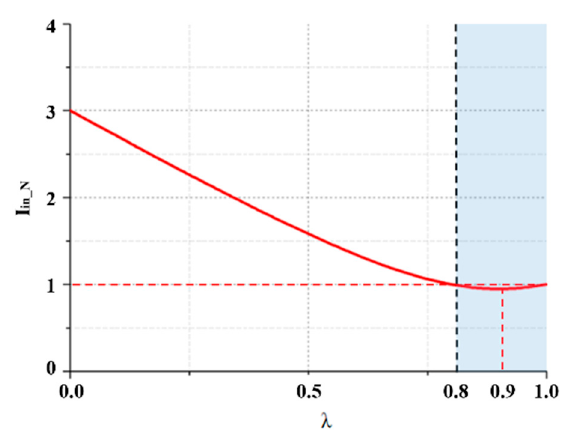
Figure 7. Normalized dual-channel input